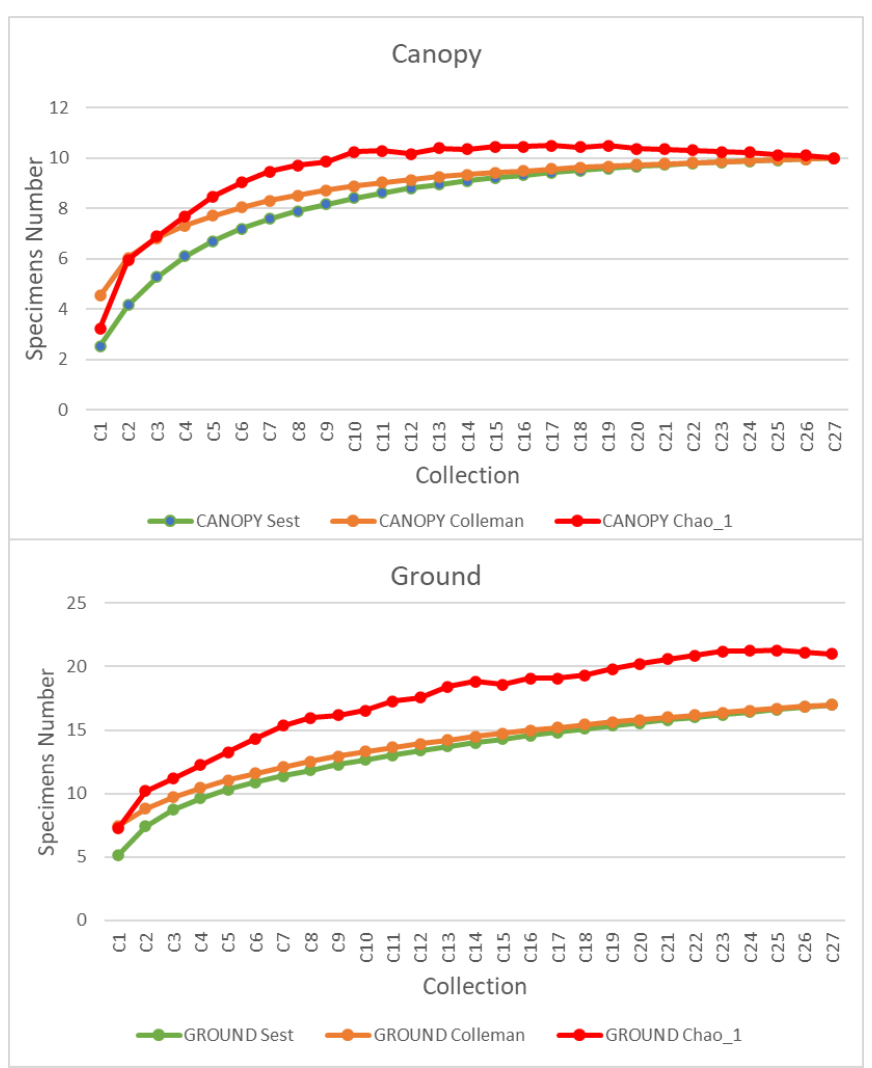
Figure 2. Species accumulation curves for Culicidae specimens collected in canopy and ground strata of the arborized savanna in the “Pé -do- Gigante” sector of the Vassununga State Park. Note: C = collection.